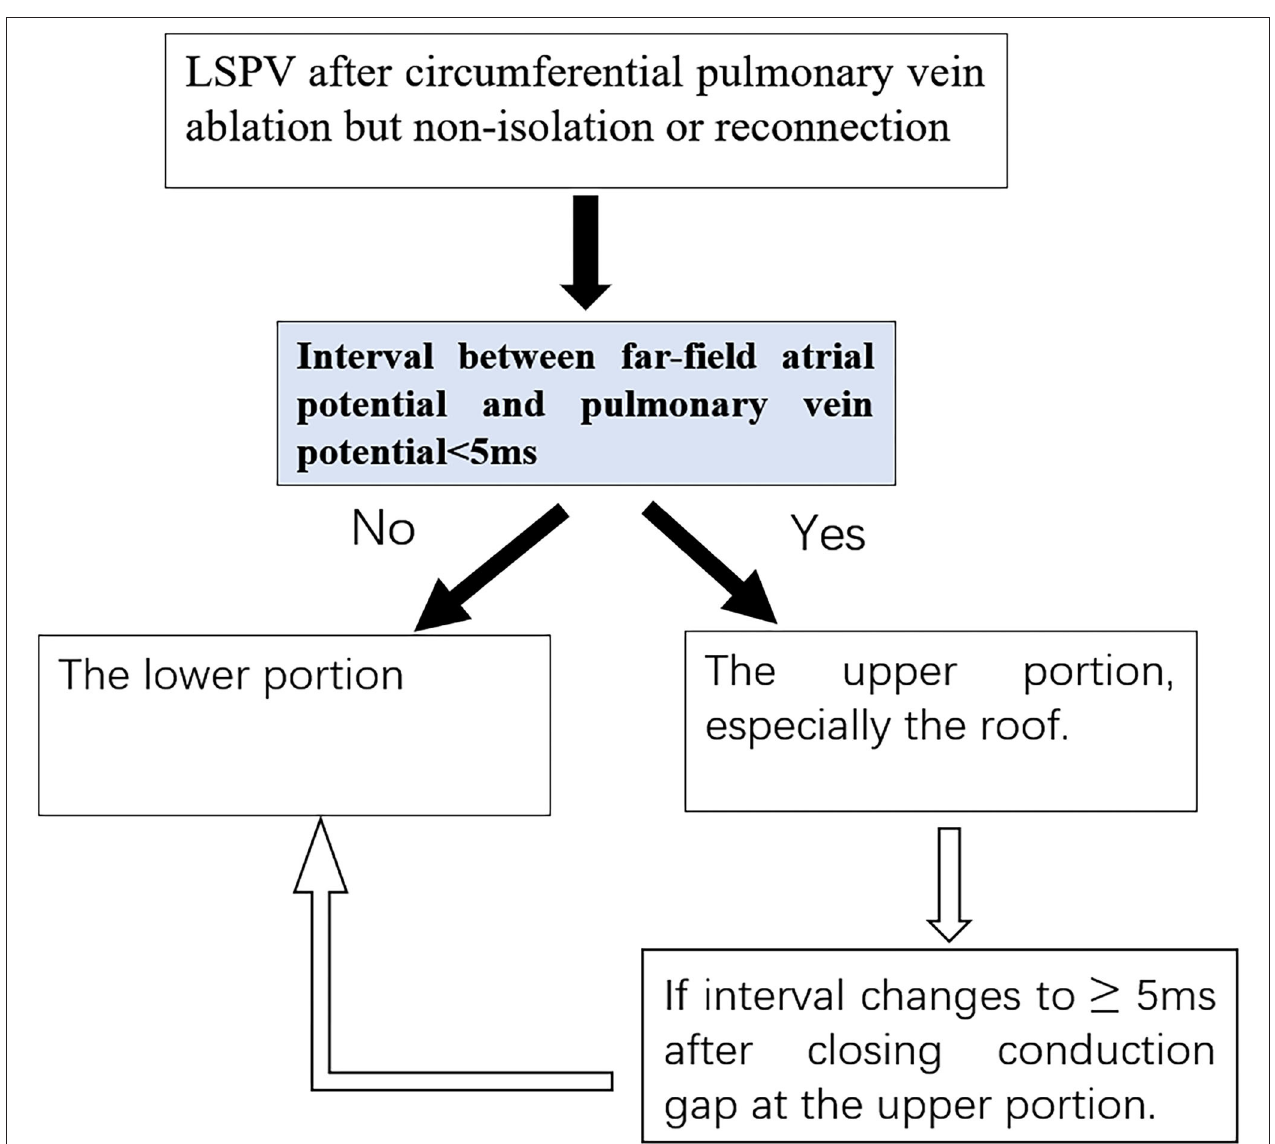
FIGURE 6 | Stepwise diagnostic for locating conduction